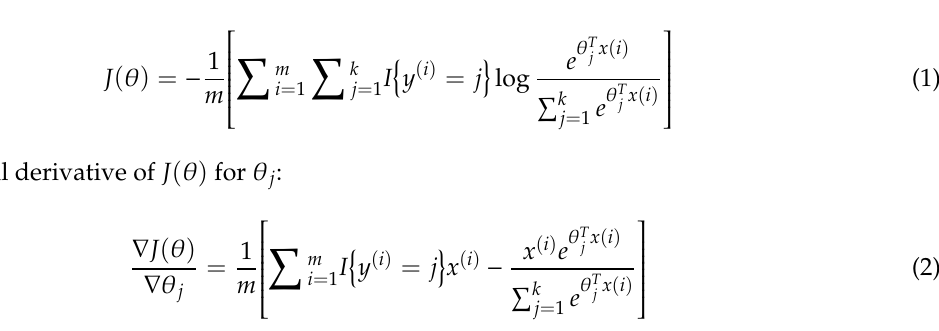
Figure 4. Structure of the convolutional neural network (CNN) in the posture-recognition model. The cost function is defined as J ( θ )